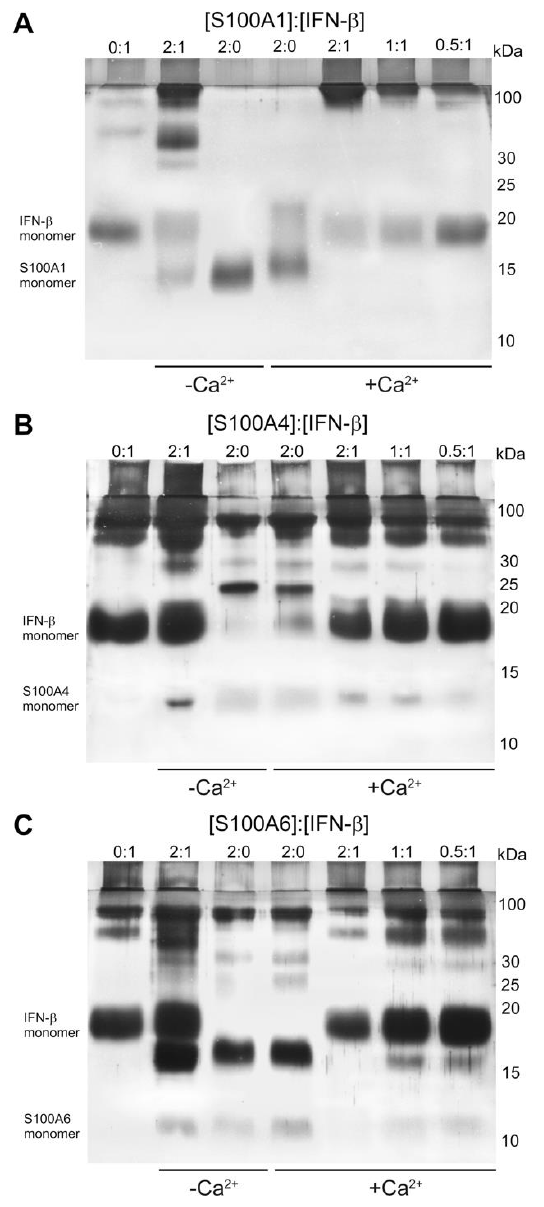
Figure 3. The results of SDS-PAGE for 5 µ M IFN- β with Ca 2 + -free / bound S100A1 (panel A ), S100A4 ( B ) or S100A6 ( C ) (S100 to IFN- β molar ratios are indicated), after crosslinking with EDAC / sulfo-NHS at 25 °C.